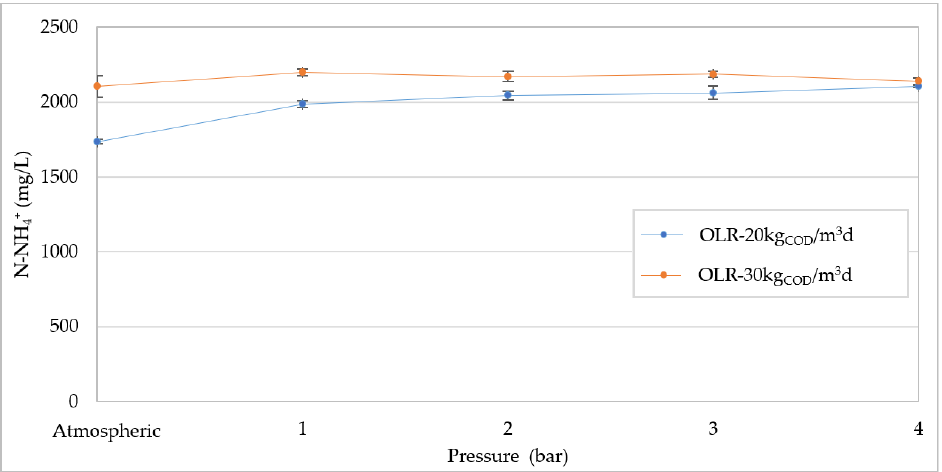
Figure 12. Ammoniacal nitrogen (N-NH 4+ ) concentration at increasing pressures for organic load rate (OLR) of 20 kg COD /m 3 d and 30 kg COD /m 3 d.